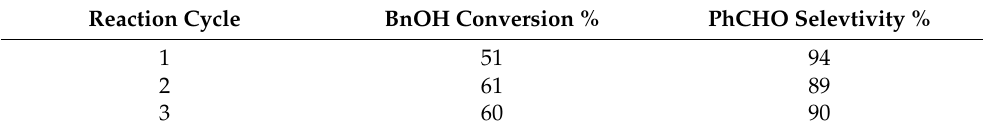
Table 5. Recyclability test of PdO X /CeO 2 -NR catalyst in BnOH to benzaldehyde (PhCHO) oxidation. Reaction Cycle